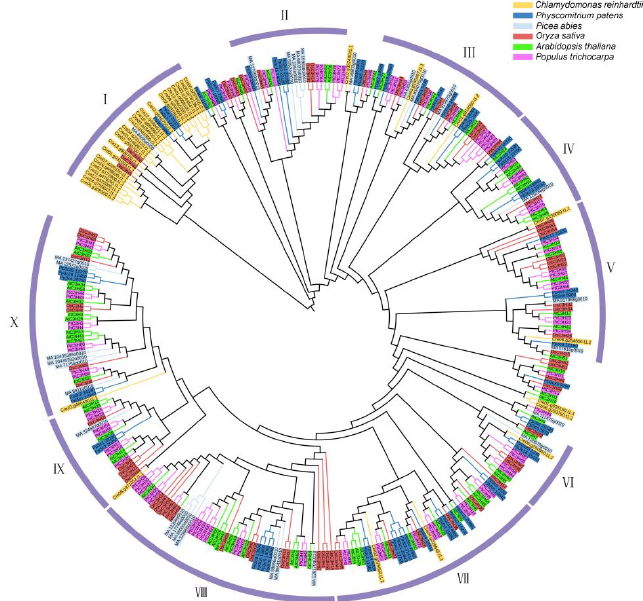
Figure 1. Phylogenetic analysis of CCCH proteins from six representative plants. The neighbor – joining (NJ) tree was constructed based on the alignment of full – length CCCH protein sequences from green algae ( Chlamydomonas reinhardtii ), moss ( Physcomitrium patens ), Arabidopsis ( Arabidopsis thaliana ), rice ( Oryza sativa ), poplar ( Populus trichocarpa ) and spruce ( Picea abies ). MEGA 6.0 was used with 1000 bootstrap replicates.